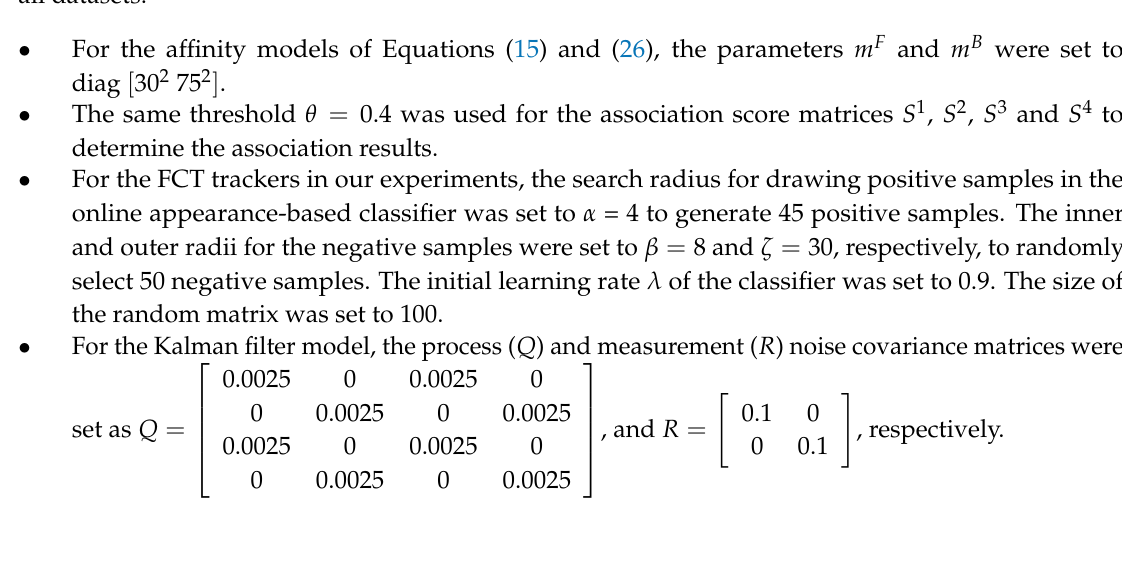
Figure 7. Performance comparison of different motion compensation-based detectors. MHI, Motion History Images; BCD, Basic Compensation-based Detector; SGM, Single Gaussian